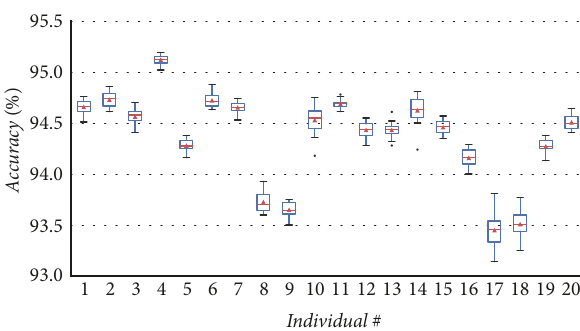
Figure 5: Boxplot showing the distribution of accuracies of the best 20 GE individuals after full training in the EMNIST Letters